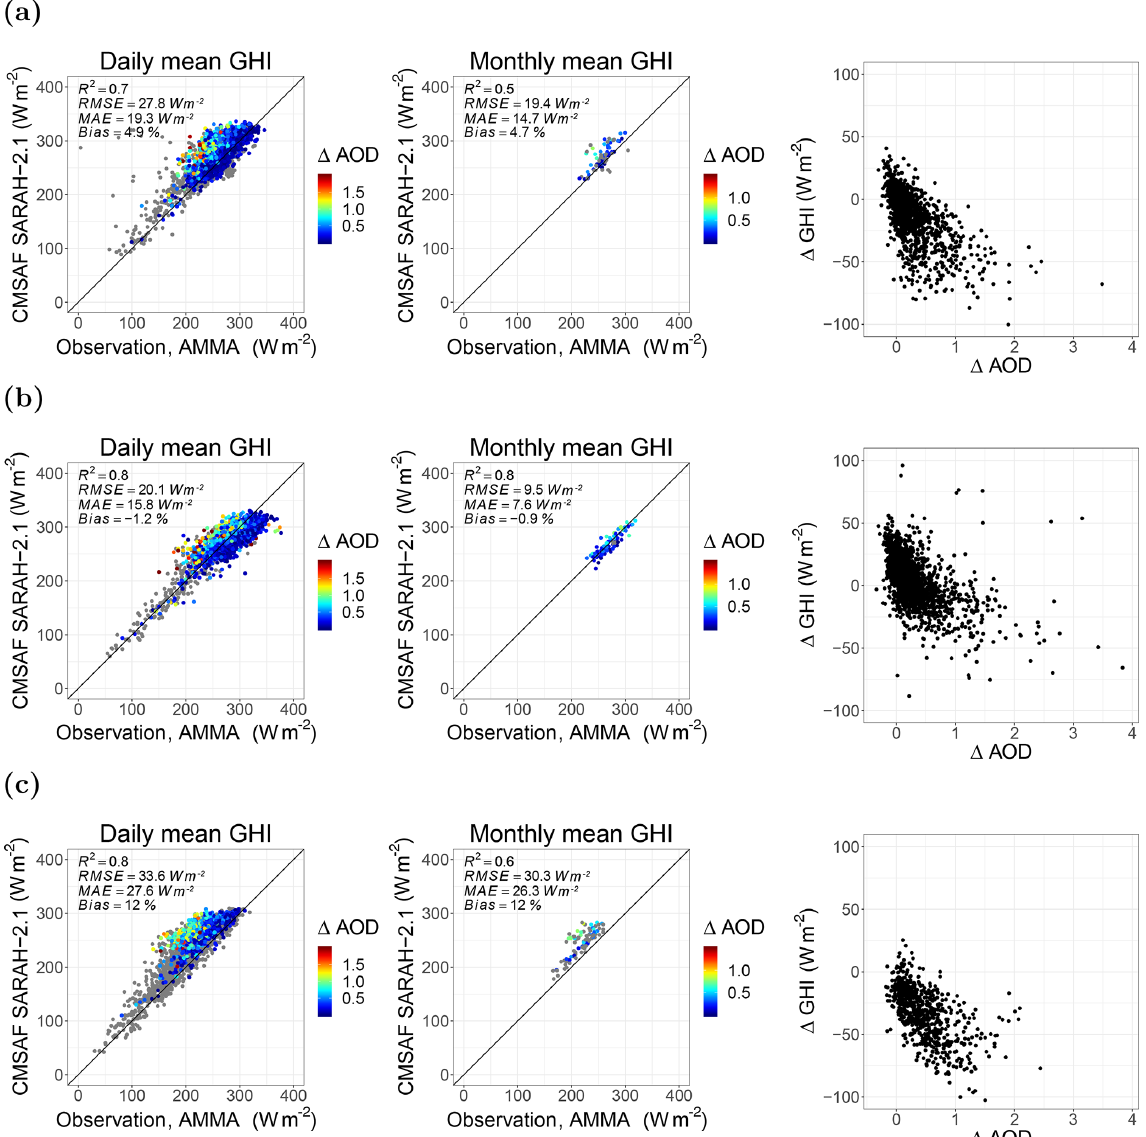
Figure 4. Comparison of the simulated and observed GHI as daily (left column) and monthly (middle column) averages at three sites over the given time horizon: (a) Agoufou (2005–2008), (b) Banizoumbou (2005–2012) and (c) Djougou (2002–2009). The difference between the measured AOD and the climatological AOD for the satellite data retrieval ( (cid:49) AOD) is indicated using color. If no measured AOD is available, the points are gray. The third column shows the correlation between (cid:49) AOD and (cid:49) GHI ( (cid:49) GHI refers to the observed GHI minus the satellite